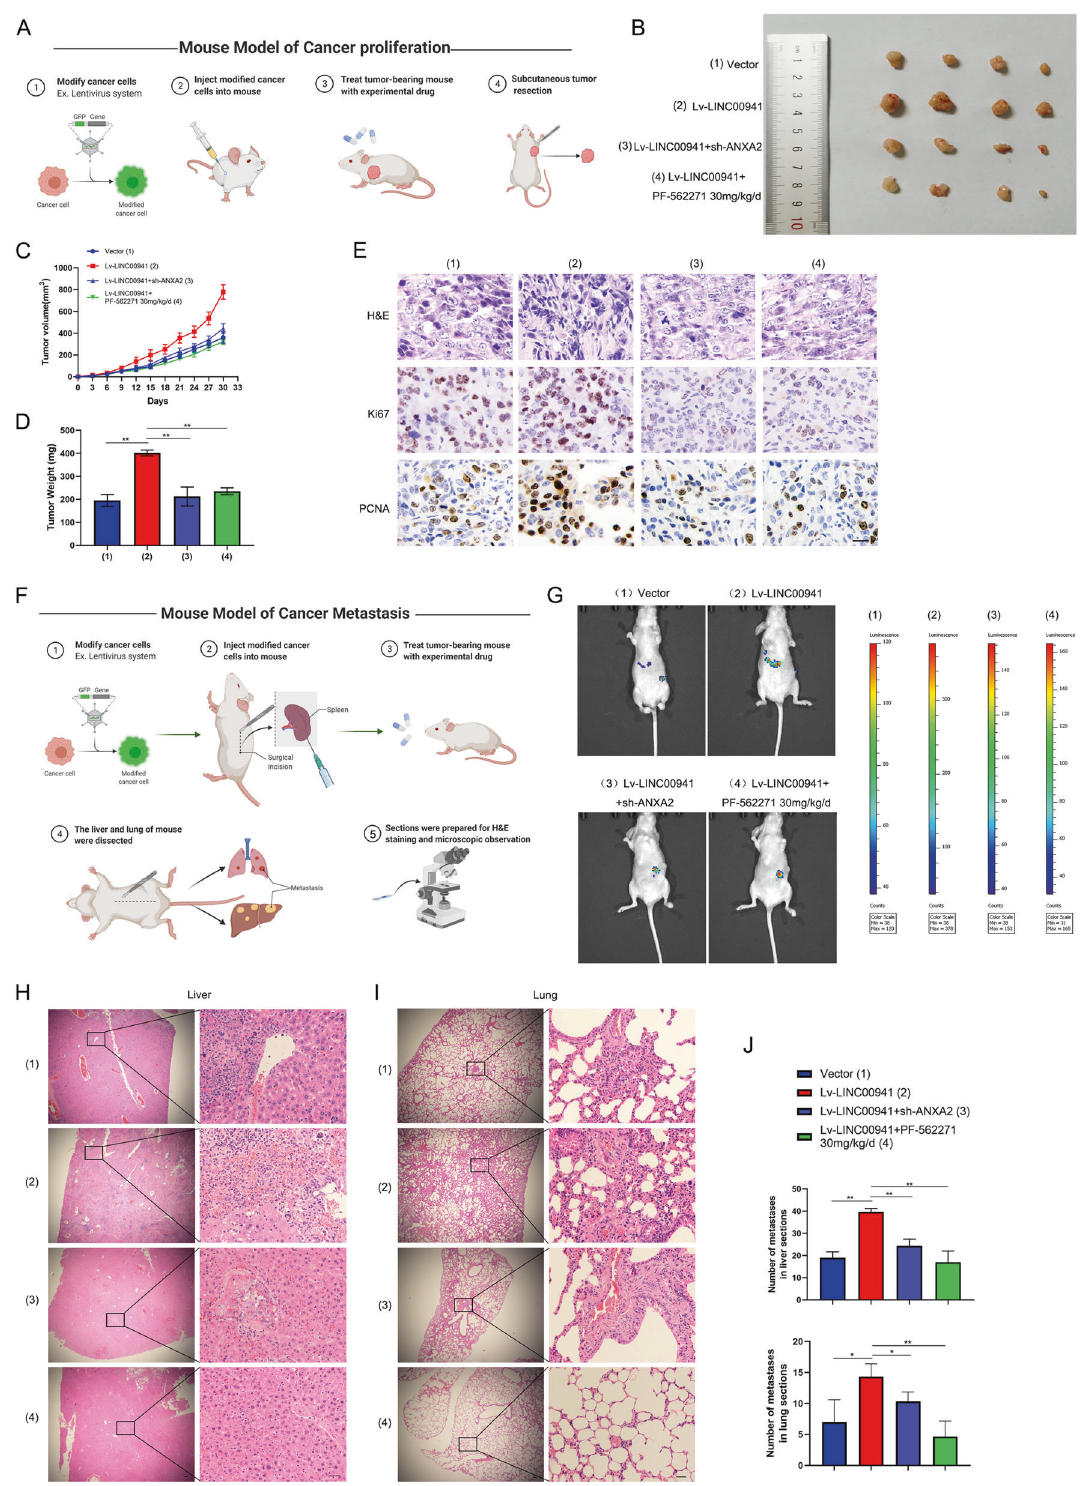
Fig. 7 LINC00941 promotes PC growth and metastasis through upregulating ANXA2 and activating FAK/AKT signaling in vivo. A The schematic diagram of the mouse model of cancer proliferation. B The photograph of tumors in empty vector group, lv-LINC00941 group, lv- LINC00941 + sh-ANXA2 group and lv-LINC00941 + PF-562271 (30 mg/kg/d) group ( n = 4/per group). C The tumor volume in these groups. D The tumor weight in these groups. E IHC analysis was performed to evaluate the expression of proliferation markers, including Ki67 and PCNA, and grade malignancy using H&E staining. F The schematic diagram of the mouse model of cancer metastasis. G The living imaging of tumors in empty vector group, lv-LINC00941 group, lv-LINC00941 + sh-ANXA2 group and lv-LINC00941 + PF-562271 (30 mg/kg/d) group ( n = 4/per group). H The liver metastases in these groups were stained with H&E. I The lung metastases in these groups were stained with H&E. J The statistical chart of liver or lung metastases. * and **, respectively, represent P < 0.05 and P < 0.01.